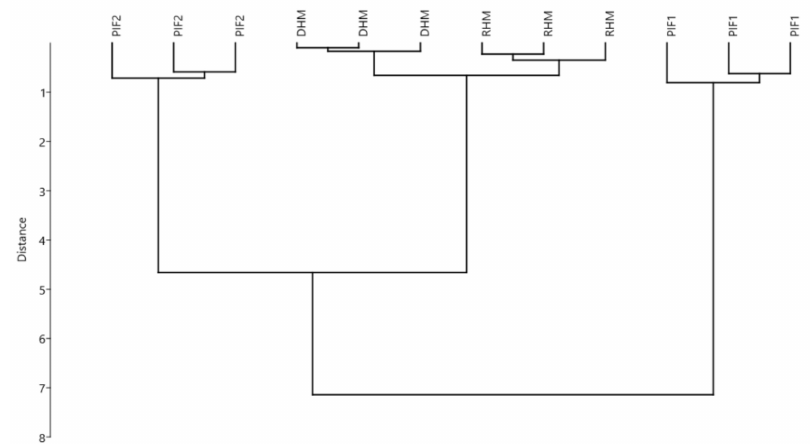
Figure 1. Multivariate cluster analysis (UPGMA algorithm – Manhattan distance) of di ff erent preterm infant formula milks (per 100 mL product). Variables ( n = 3): antioxidant capacities (measured as TEAC and DPPH), protein carbonyl and malondialdehyde contents. RHM: raw human